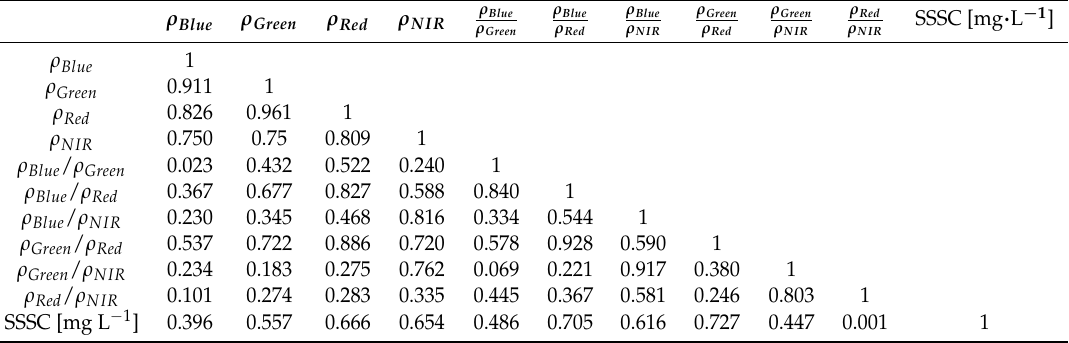
(Table A2) and the comparison between statistical models for estimating SSC (Table A3). Table A2. Correlation matrix for the log spectral values of each band and ln(SSSC).